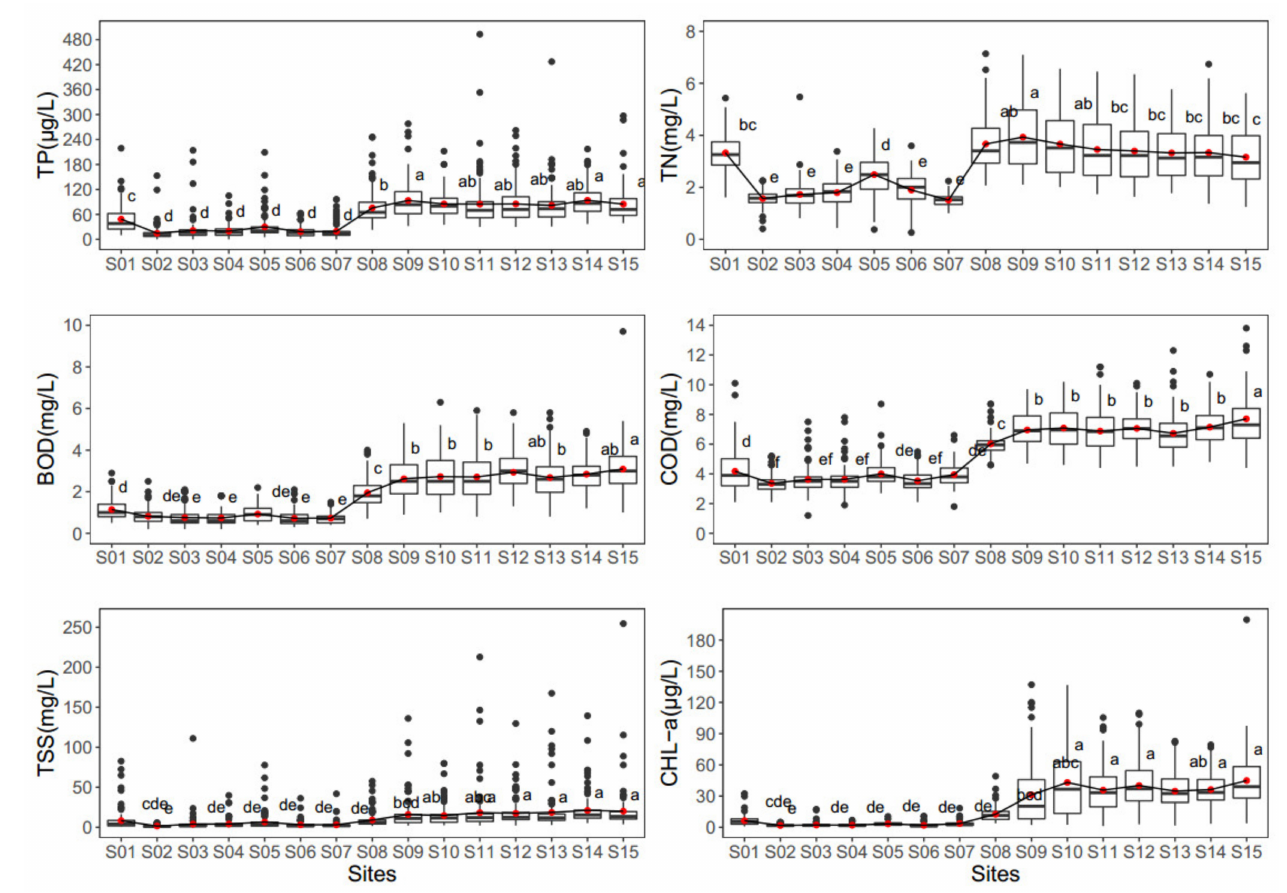
Figure 2. Site variations of water quality parameters in the Geum River basin (TP, total phosphorus; TN, total nitrogen; BOD, biological oxygen demand; COD, chemical oxygen demand; TSS, total suspended solids; CHL-a, chlorophyll-a. The red dots indicate the mean value, the first highest mean receives the letter “a”, the second, third, fourth, and fifth highest mean receives the letter “b”, “c”, “d” and “e”, respectively, and means with no significant difference receive the same